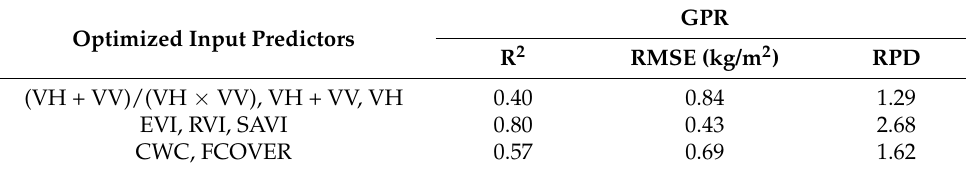
Table 6. Performance of the optimized GPR models on estimating maize